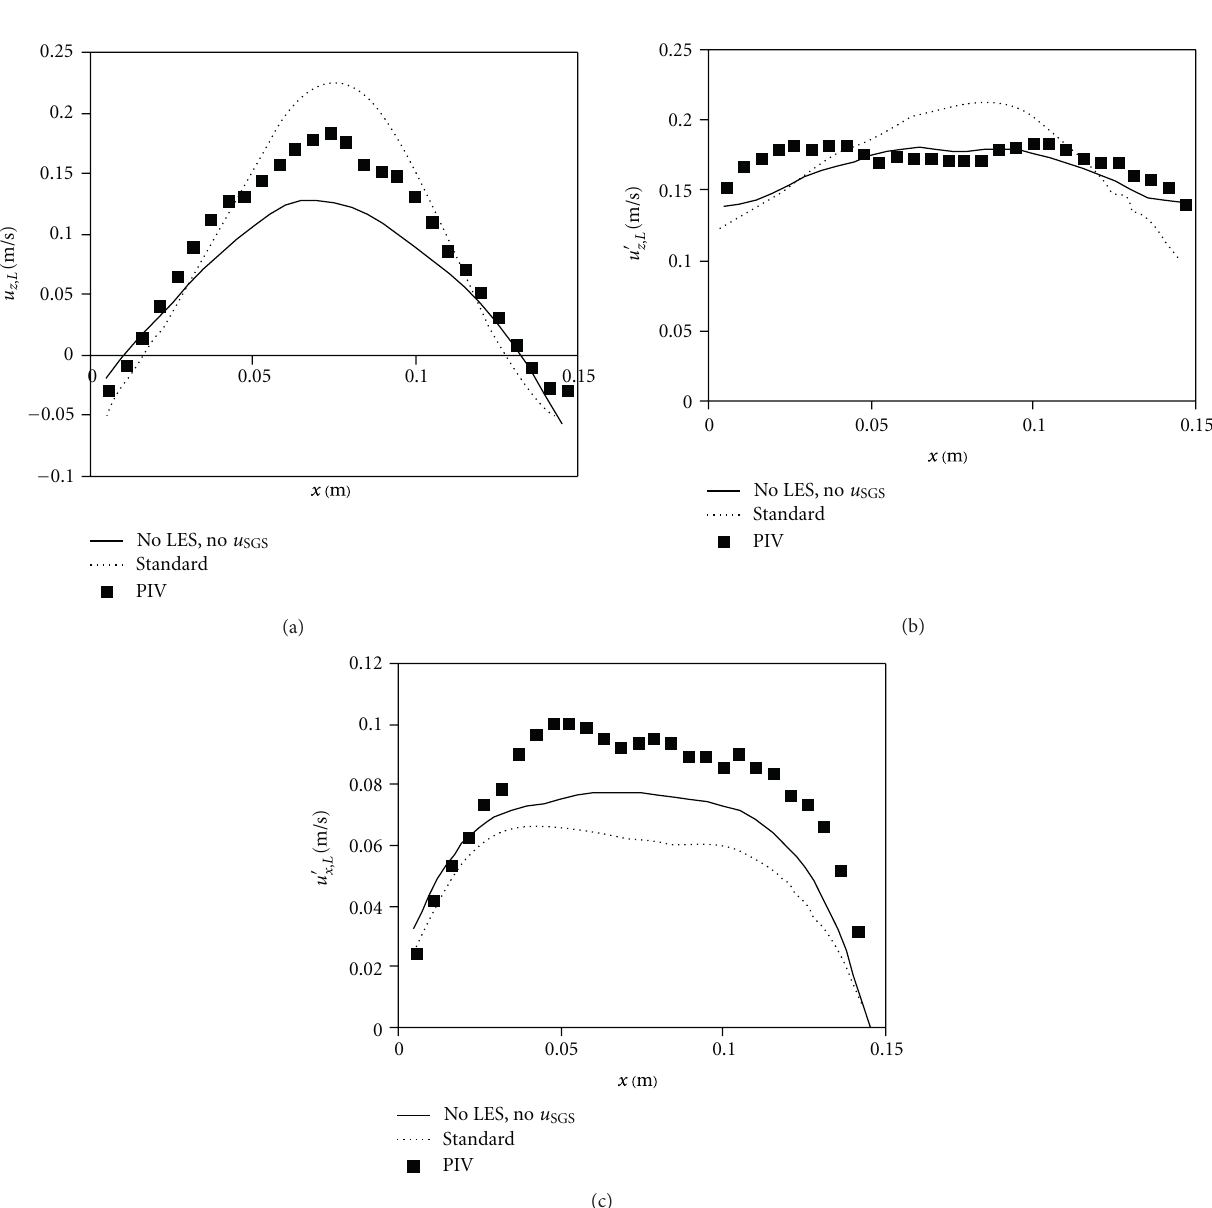
prediction of the instantaneous flow features, including liquid velocity fluctuations and unsteady bubble dispersion